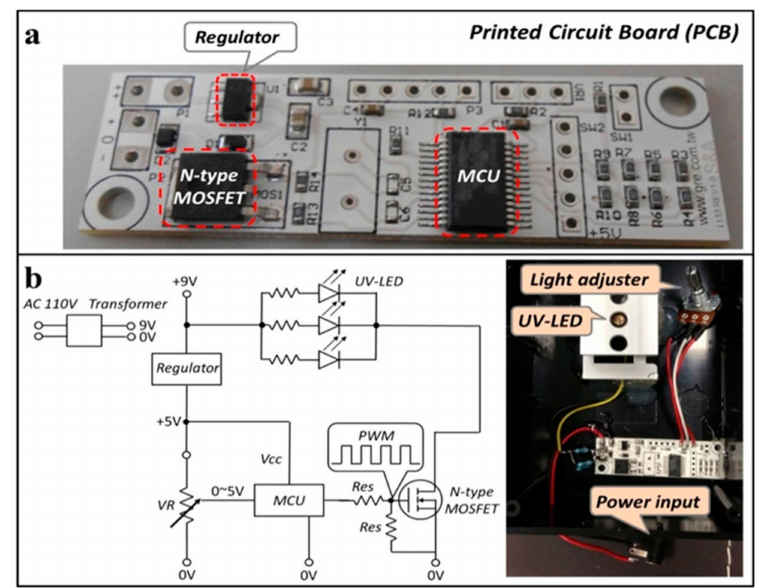
Figure 2. ( a ) The designed electronic components on a printed circuit board (PCB) and ( b ) the schematic diagram of the portable image recording device. The power input is linked with an AC 110 V transformer, and the light adjuster is operated to alternate the variable resistance